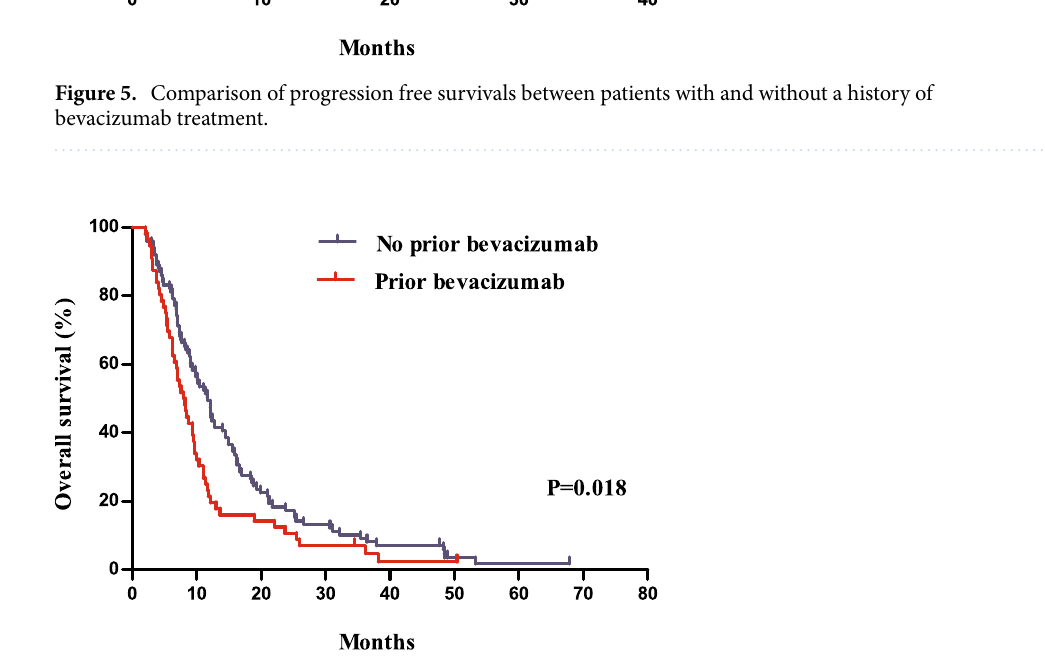
Figure 6. Comparison of overall survivals between patients with and without a history of bevacizumab